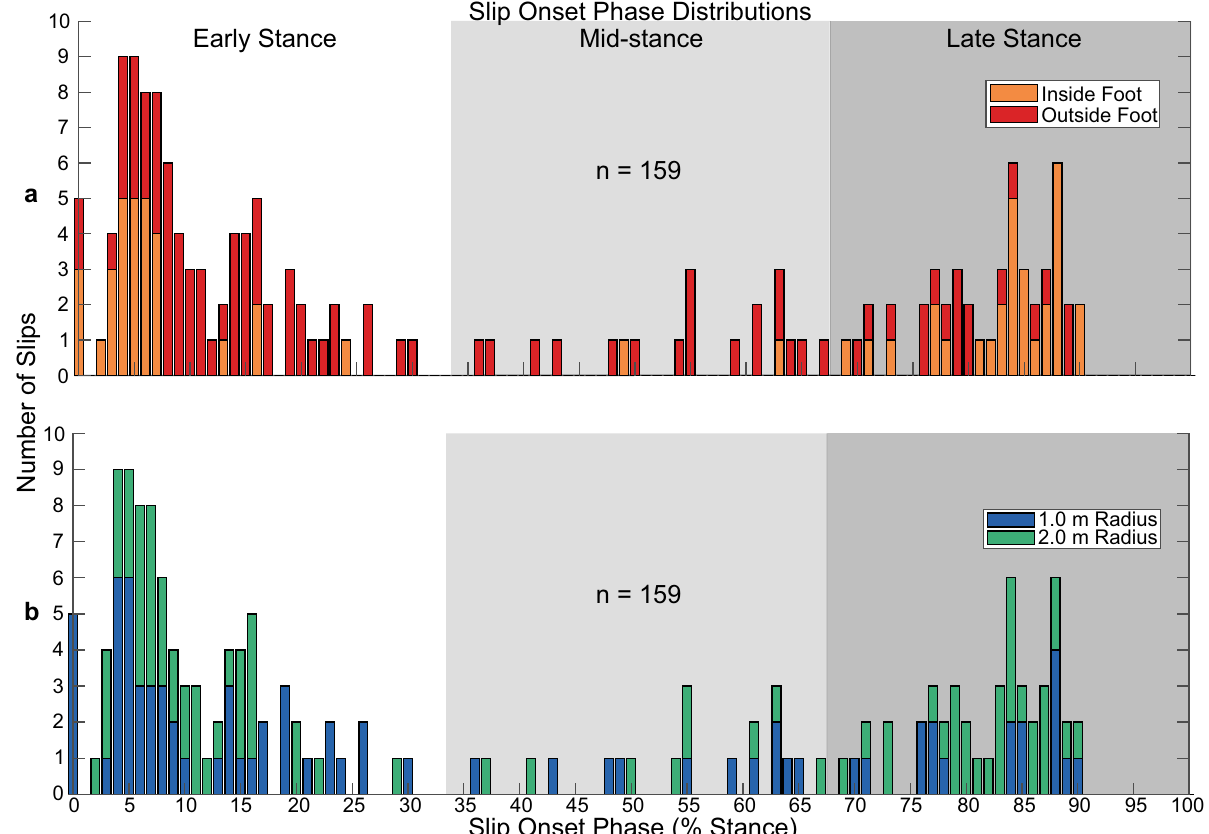
Figure 3. The distribution of successfully delivered slips across stance phase, color-coded by ( a ) slipped foot relative to the path and ( b ) path radius. Bars at 0% stance phase represent trials where the slipped foot’s CoM velocity never reached zero after heel strike and therefore slip onset occurred simultaneously with heel strike. Successfully delivered slips were concentrated in early and late stance, and those that did occur during mid- stance were almost exclusive to the outside